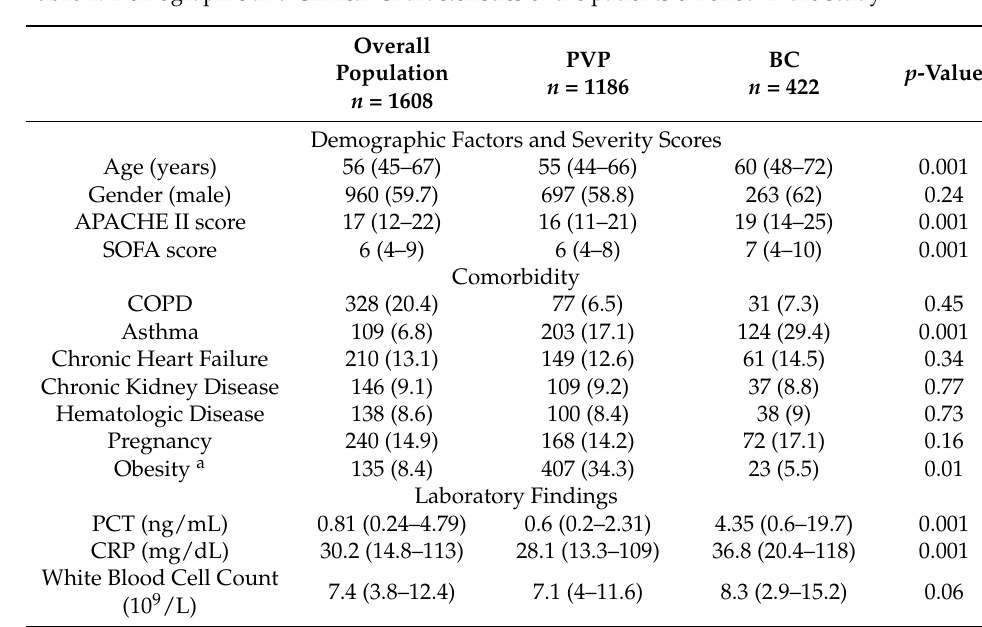
Table 1. Demographic and Clinical Characteristics of the patients enrolled in the study.